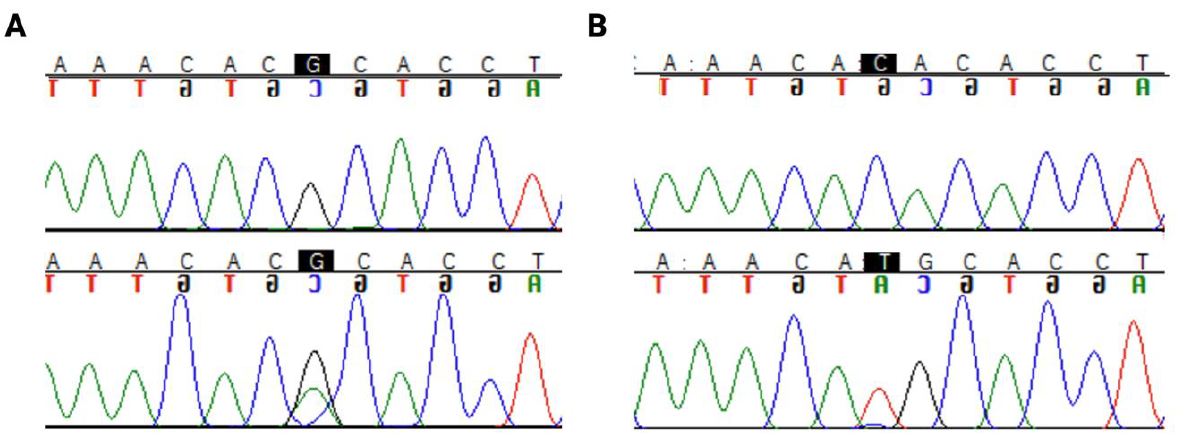
Figure 1. TP53 hotspot mutations in codon 273: ( A ) R273C (c.817C>T) ( B ) R273H (c.818G>A). The nucleotide of interest is highlighted in black. The top row of the sequence is the reference sequence, and the bottom row is the mutant sequence.